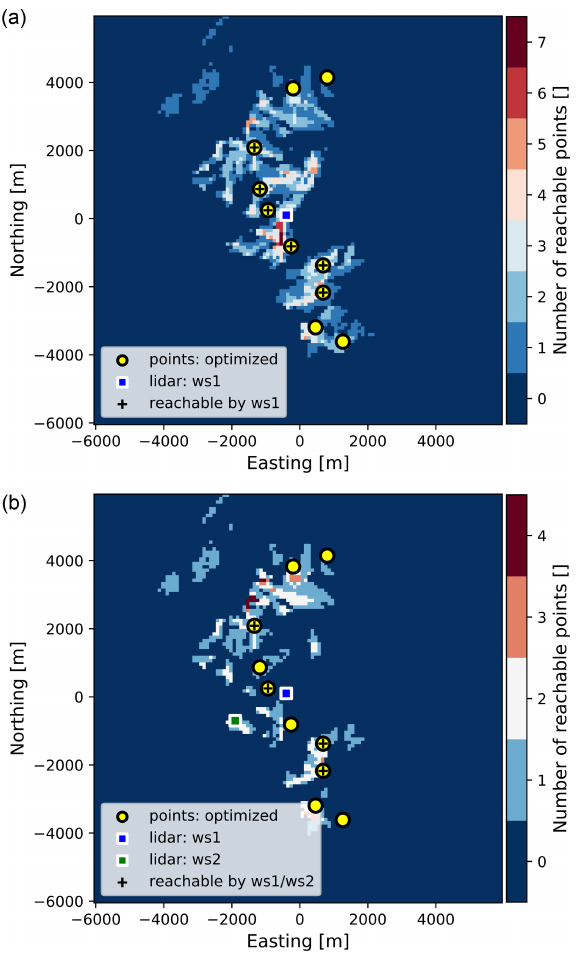
Figure 16. Placing lidars at the Turkish site: (a) locating first lidar at the combined layer; (b) locating second lidar at the second lidar placement layer.